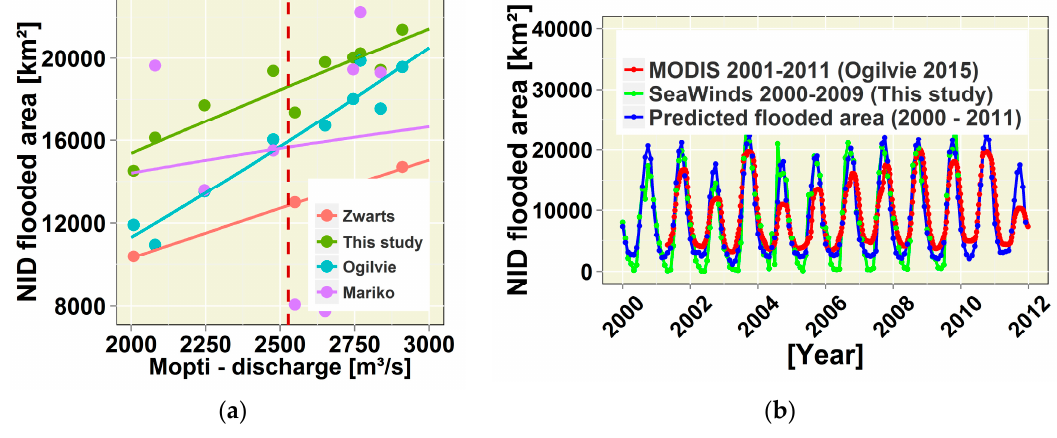
Figure 7. ( a ) Comparison with other results on the area flood extent; ( b ) Monthly flooded surface area.